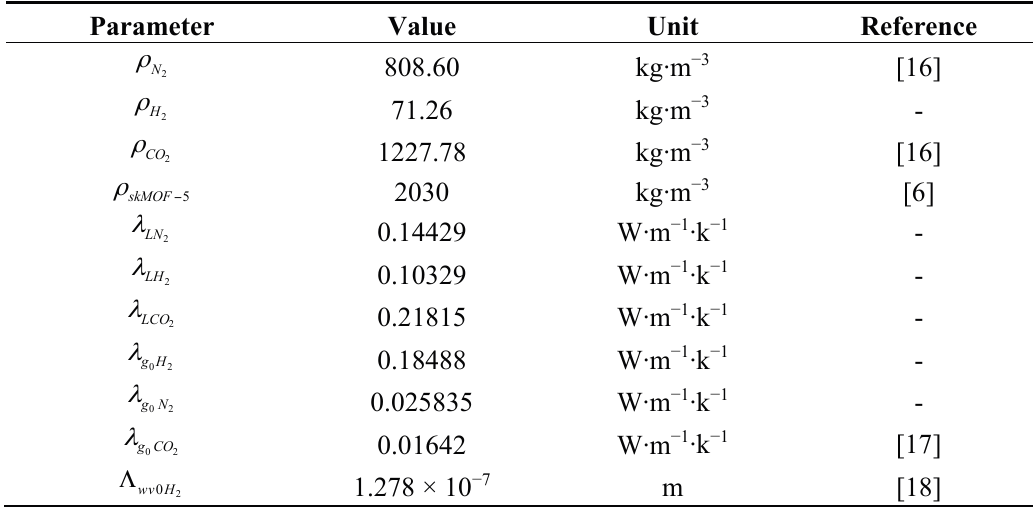
Table 1. Constant parameters (the missed parameters of density and thermal conductivity in the reference are from REFPROP